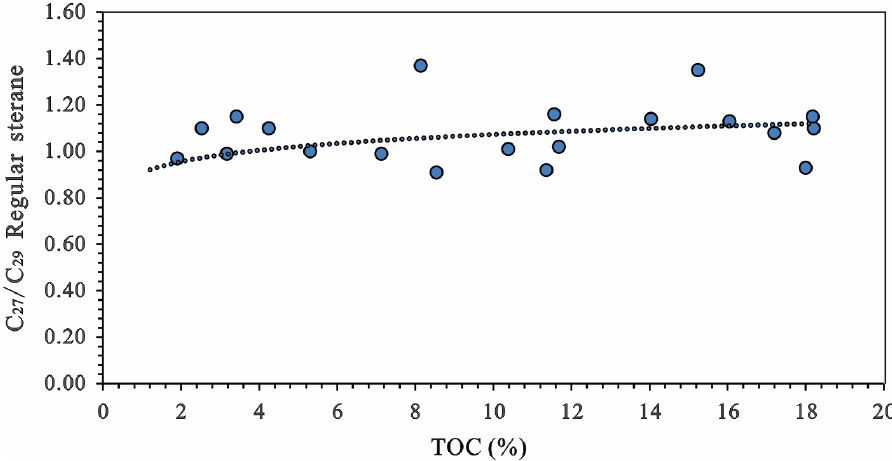
Figure 10. The cross-plot of the ratios of C 27 /C 29 regular sterane versus TOC contents. In summary, the distribution of n -alkanes, acyclic isoprenoids and regular steranes varied in all samples. Generally, the average of the wax index, TAR, Pr/nC 17 and Ph/nC 18 ratios and relative content of C 29 regular steranes for source rocks from C7-2 is higher than that of source rocks from C7-3. This suggests that terrigenous source input is more abundant in C7-3. Moreover, a high TOC content basically corresponds to low